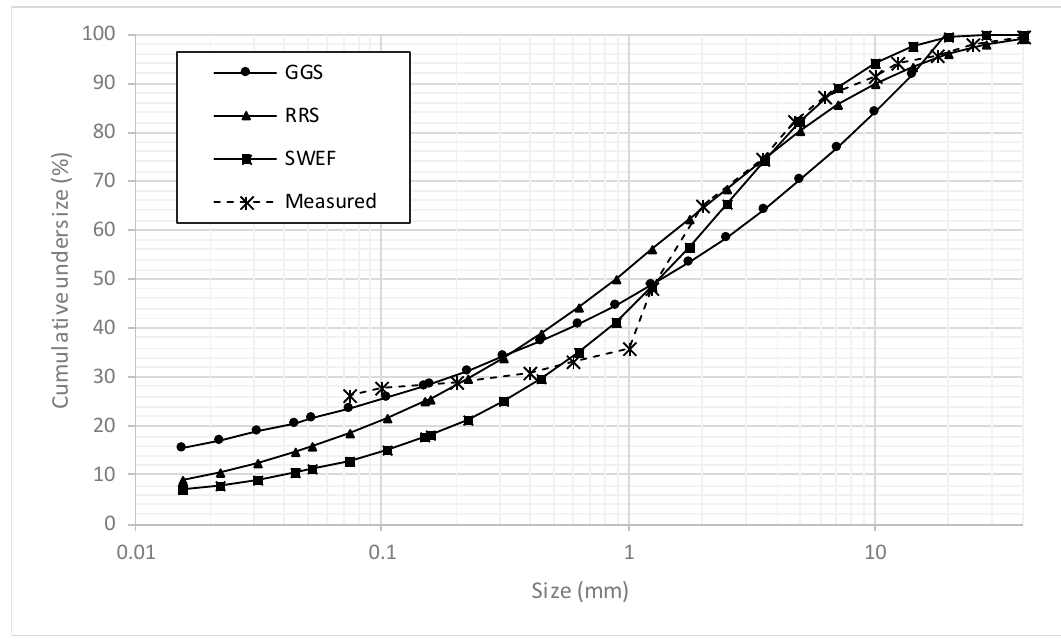
Figure 1. Size distribution of the ore particles of the fresh feed to the mill.